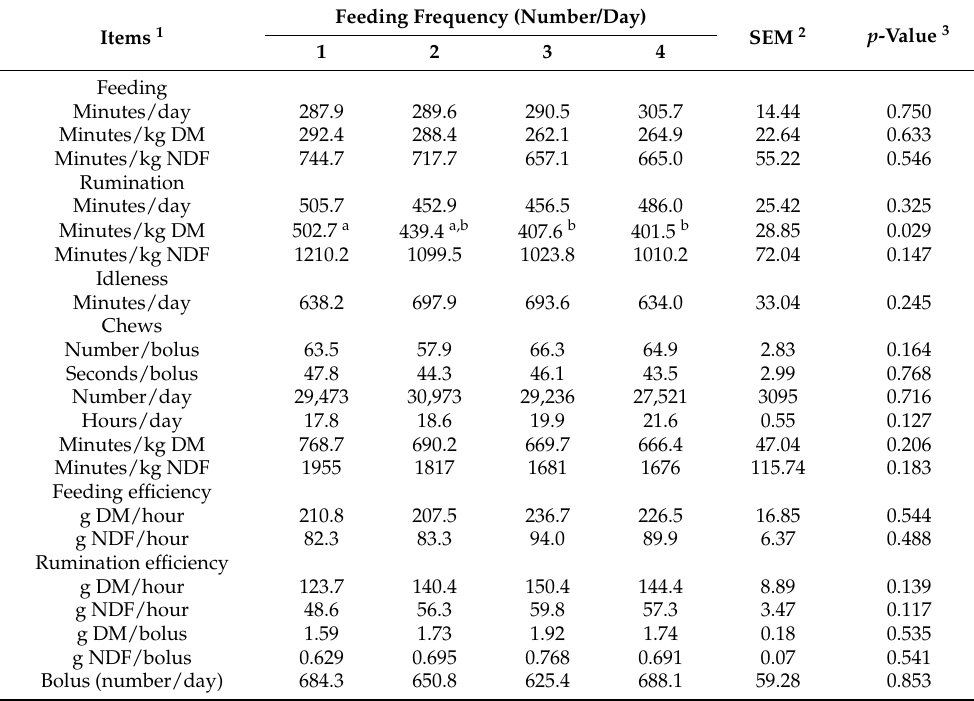
Table 3. Feeding behavior of male feedlot lambs subjected to different feeding